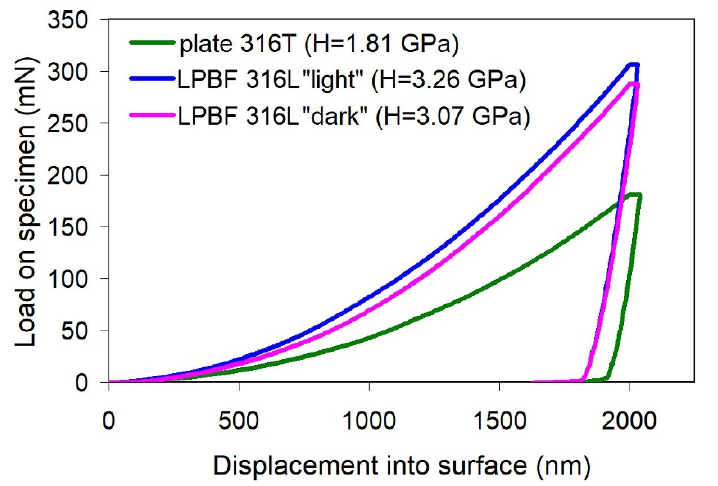
Figure 6. Representative load/displacement curves of as-received plate 316T and as-received LPBF 316L specimens.